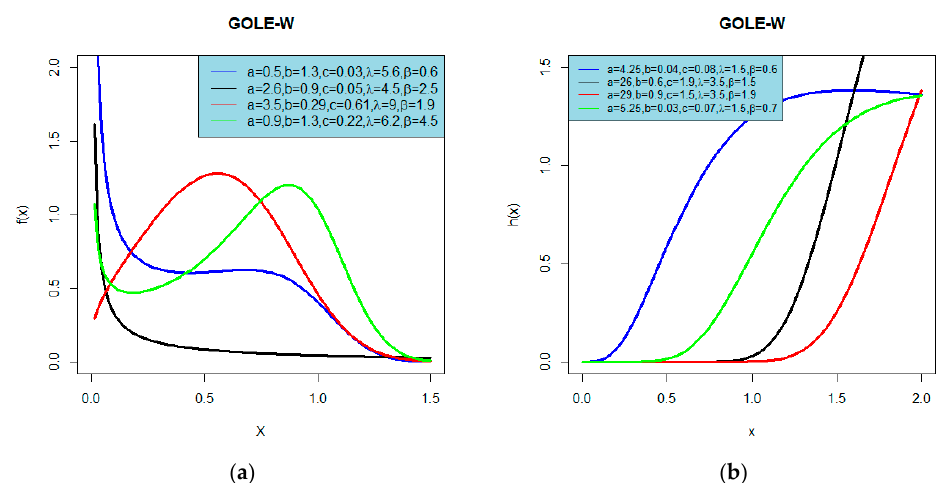
Figure 1. ( a ) Density function and ( b ) hazard rate plots of the GOLE-W distribution for different parameter values.